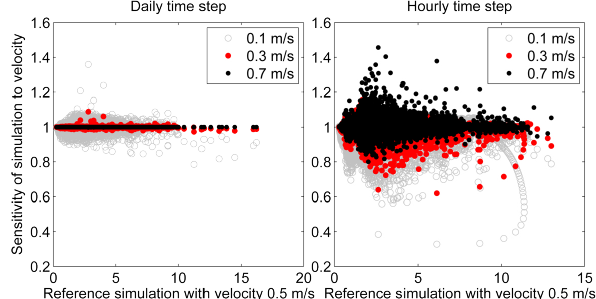
Figure 9. Sensitivity of the discharge simulation with respect to the in-stream flow velocity plotted against the reference simulation with parameters of Table 3 and velocity of 0.5ms − 1 ; the sensitivity is expressed as the relative difference to the reference simulation for each time